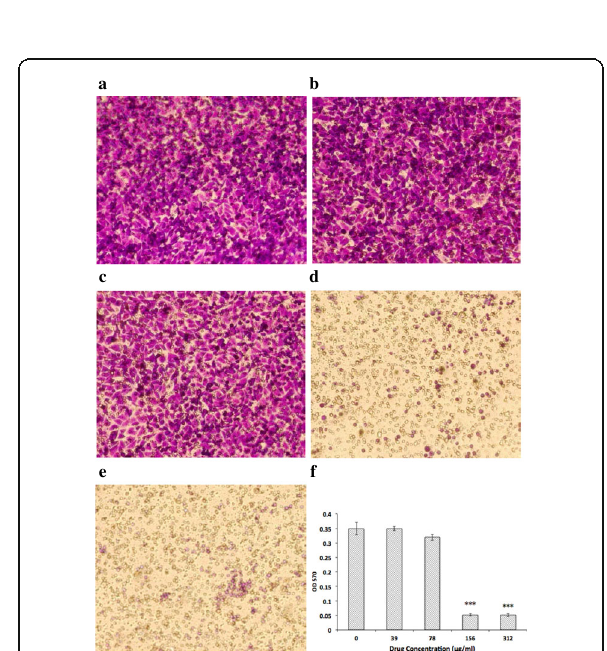
Fig. 4 Effect of oridonin on HUVEC invasion. HUVECs were treated with various concentrations (39 – 312 μ g/ml) of oridonin. a control group; b 39 μ g/ml oridonin group; c 78 μ g/ml oridonin group; d 156 μ g/ ml oridonin group; e 312 μ g/ml oridonin group; f OD570 comparison. The asterisks indicate statistically significant differences for oridonin groups compared with the control group (*** P <